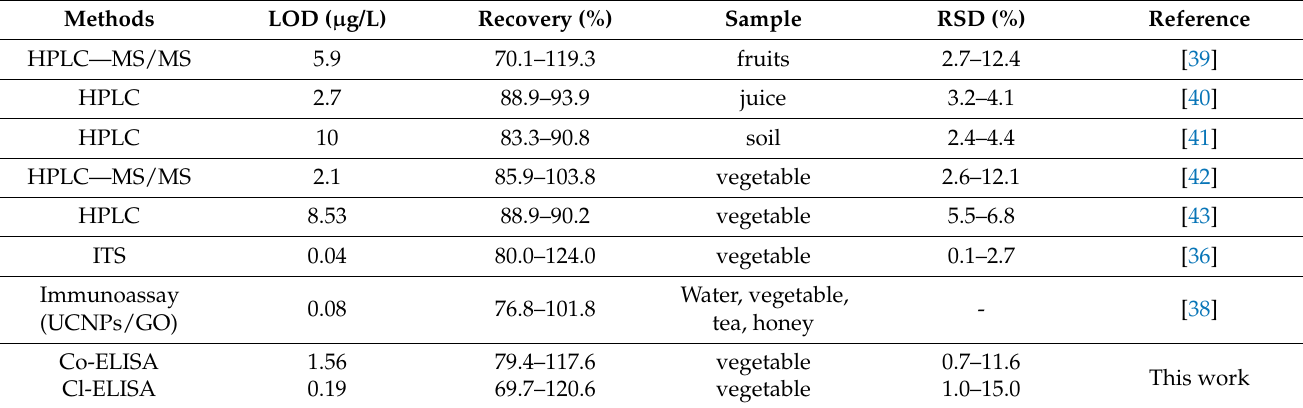
Table 5. Comparison of instruments detecting IMI (n = 3).